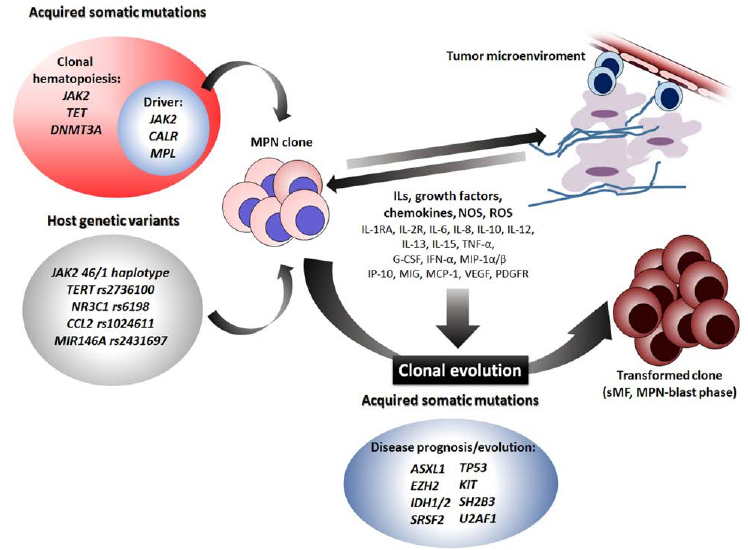
Figure 1. Elements contributing to onco-inflammation in MPNs. The chronic inflammatory state in MPNs is determined by (i) inherited genetic variants of the host; (ii) acquired somatic mutations leading to a premalignant condition (clonal hematopoiesis) first and then to malignant clone expansion; (iii) ILs, growth factors, chemokines, NOS, and ROS released both at a local and a systemic level; (iv) tumor microenvironment (bone marrow immune, stromal, and endothelial cells). All these elements act in turn on the MPN clone eliciting its transformation into a more aggressive disease (sMF or / and blast phase). ILs: interleukins; NOS: Nitric Oxide Species; ROS: Reactive Oxygen Species; sMF: secondary